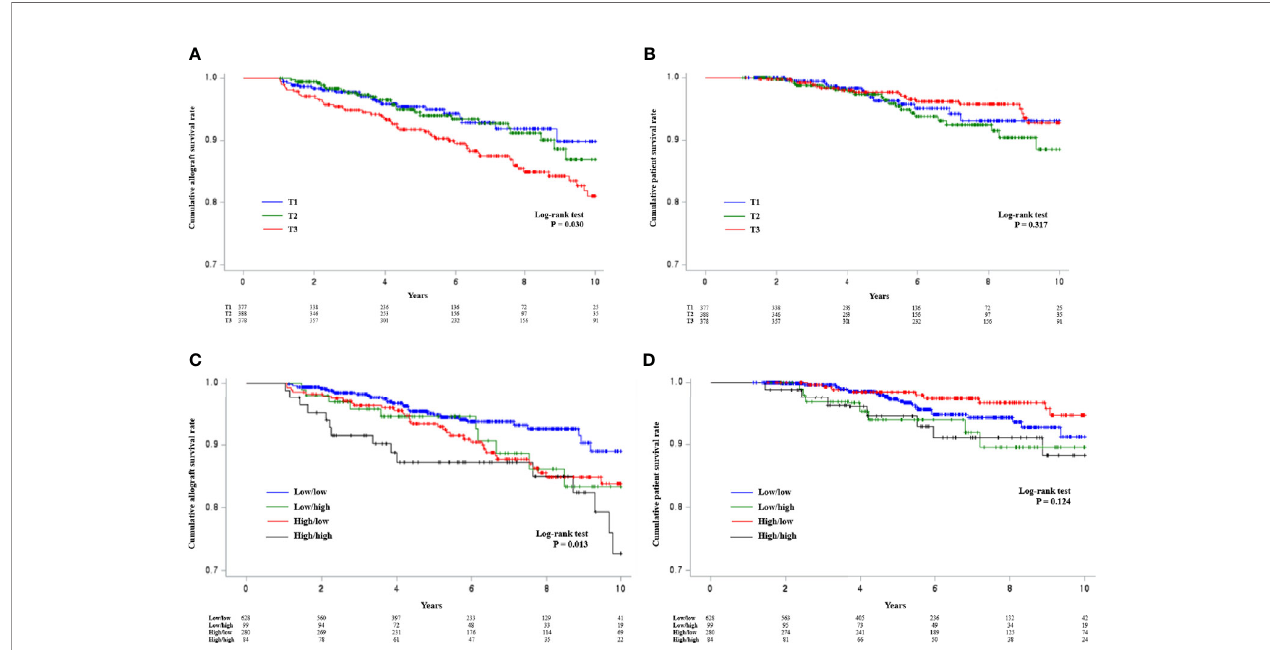
FIGURE 2 | Kaplan – Meier analysis of allograft survival according to TAC-C0-TWCV tertiles up to post-transplant fi rst year and TAC-C0-TWCV tertiles during the post- transplant 0 – 1 st and 1 st – 2 nd years. (A) The cumulative allograft survival rate was signi fi cantly lower in the T3 group than in the other groups. However, there was no difference between the T1 and T2 groups. (B) The cumulative patient survival rates did not differ according to the TAC-C0-TWCV tertiles up to post-transplant fi rst year. (C) The high/high group had a signi fi cantly low cumulative allograft survival rate. In terms of intermediate outcomes, the allograft survival rates of the low/high and high/low groups were similar, and the low/low group had the highest allograft survival rate. (D) The cumulative patient survival rates did not differ according to the TAC- C0-TWCV tertiles during the post-transplant 0 – 1 st and 1 st – 2 nd years. TAC-C0, tacrolimus trough level; TWCV, time-weighted coef fi cient